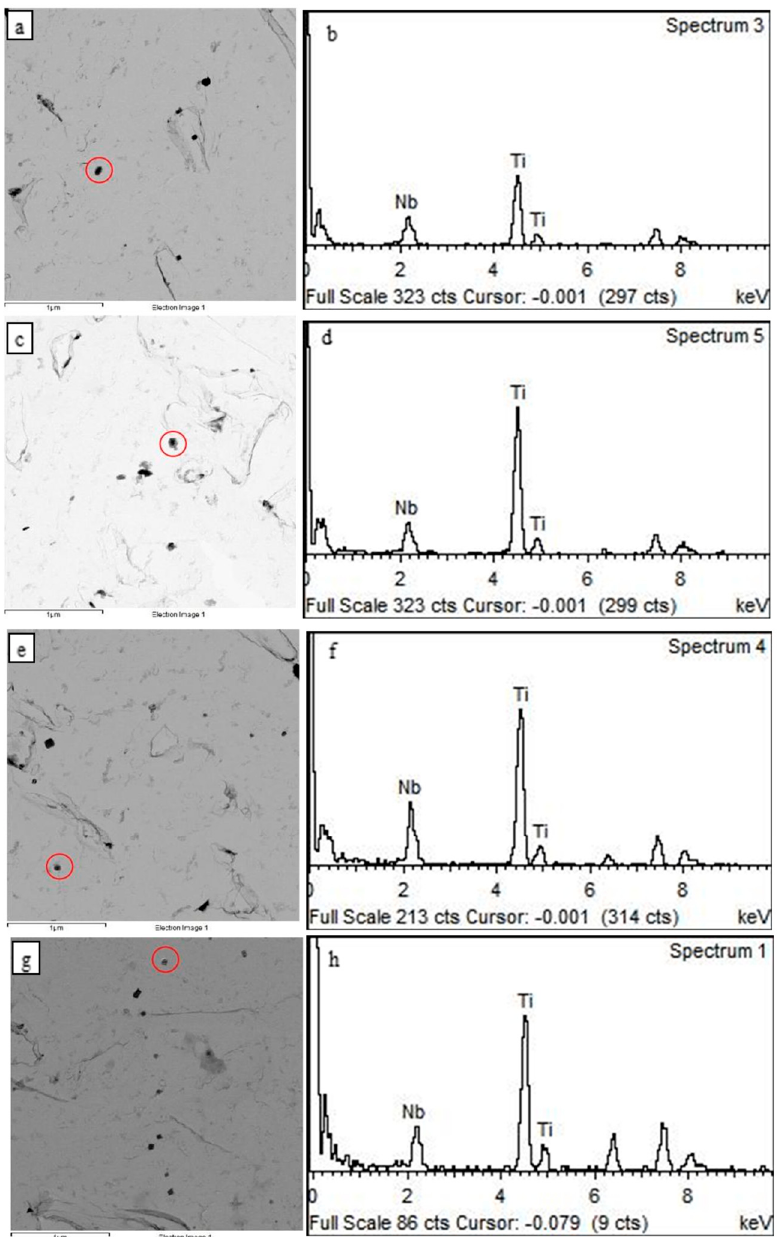
Figure 9. TEM observations of precipitates in samples comprising ( a ) 0.15 wt.% Si, ( c ) 0.36 wt.% Si, ( e ) 0.48 wt.% Si, and ( g ) 0.77 wt.% Si. The EDX results of precipitates marked by the red circle in the corresponding figure are shown in ( b , d , f , h ) respectively.